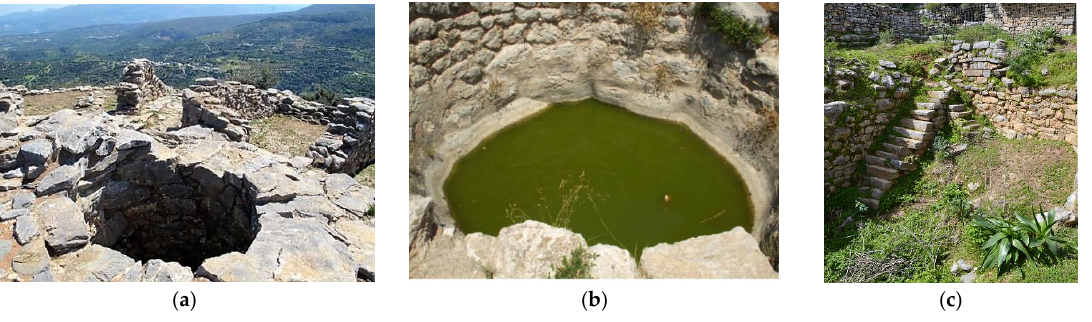
Figure 6. Comparison of Minoan and Mycenaean cisterns with those in Classical times: ( a ) Cistern in the Hamezi Minoan village in eastern Crete, ( b ) cistern in Mycenae, and ( c ) cistern in Classical Dreros in the eastern Crete (photos: A. N. Angelakis).